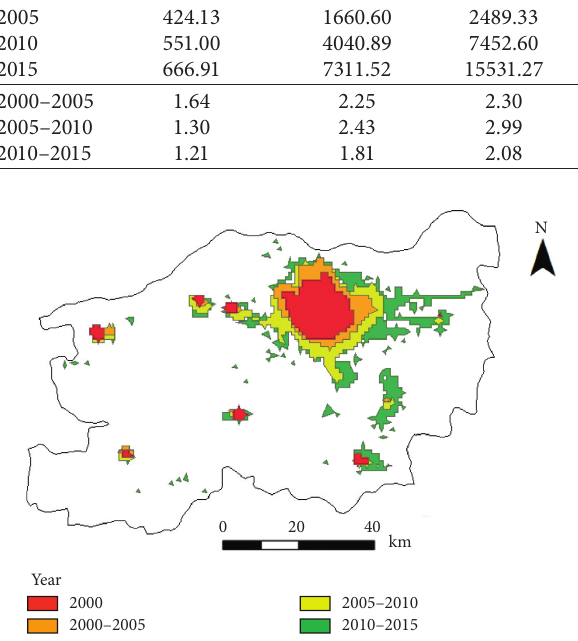
Figure 5: Urban built-up land sprawl during the period of 2000–2015, as detected using night-time light data.